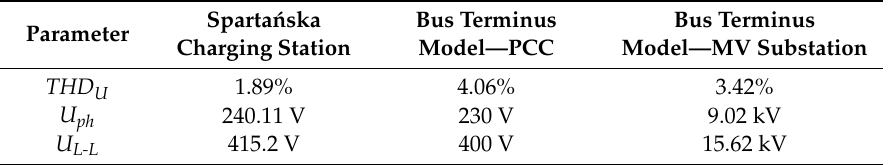
Table 7. Voltage parameters recorded during research.